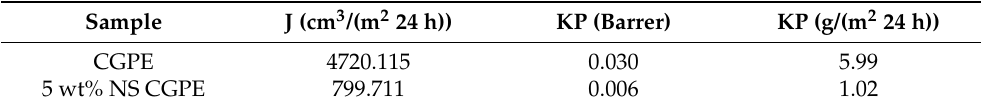
Table 2. Summary of the permeating flow (J) and permeability coefficient (KP), obtained at 25 ◦ C, 1 bar, and 0% of relative humidity for CGPE and 5 wt% NS